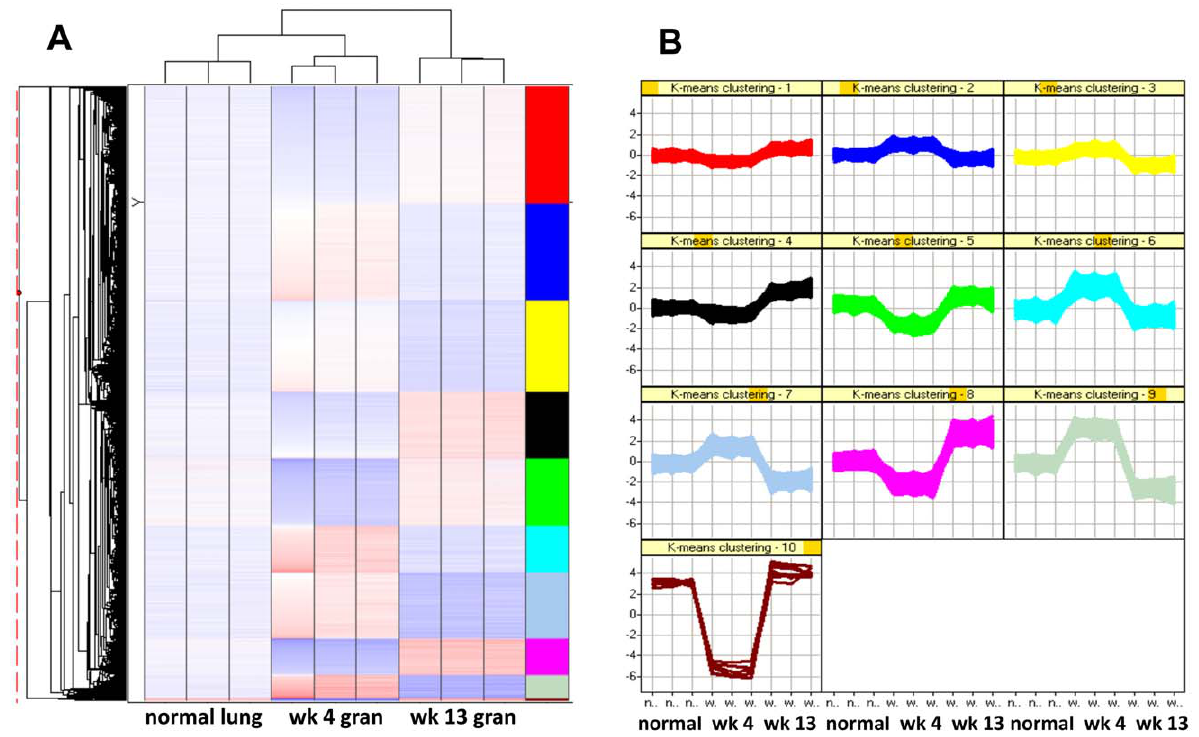
Figure 2. Hierarchical and profile cluster analysis of the transcriptome of early and late granulomas. Microarray analysis of genes expressed in a differential manner between normal lung, and granulomas from Mtb infected NHPs at week 4 and week 13, using hierarchical (A) as well as profile based (K-means) clustering (B). Clustering was performed using Spotfire DecisionSite for Functional Genomics, using data from triplicate biological samples. The coloring scheme for the hierarchical cluster is white -no change in expression, blue – lower expression in lesion samples relative to normal lung, and red – higher expression in lesion samples relative to normal lung. The hierarchical cluster is sorted by the results obtained by dividing the dataset into 10 distinct K-means clusters, with the right column showing the identical color scheme as the k-means clusters diagram. (Fig. S2A & S2B), nitric oxide production (Fig. S3A & S3B), MHC antigen presentation (Fig S4A & S4B) differentiation of T helper cells (Fig. S5A & S5B) and maturation of DCs (Fig. S6A & S6B) were significantly perturbed in both early and late lesions.